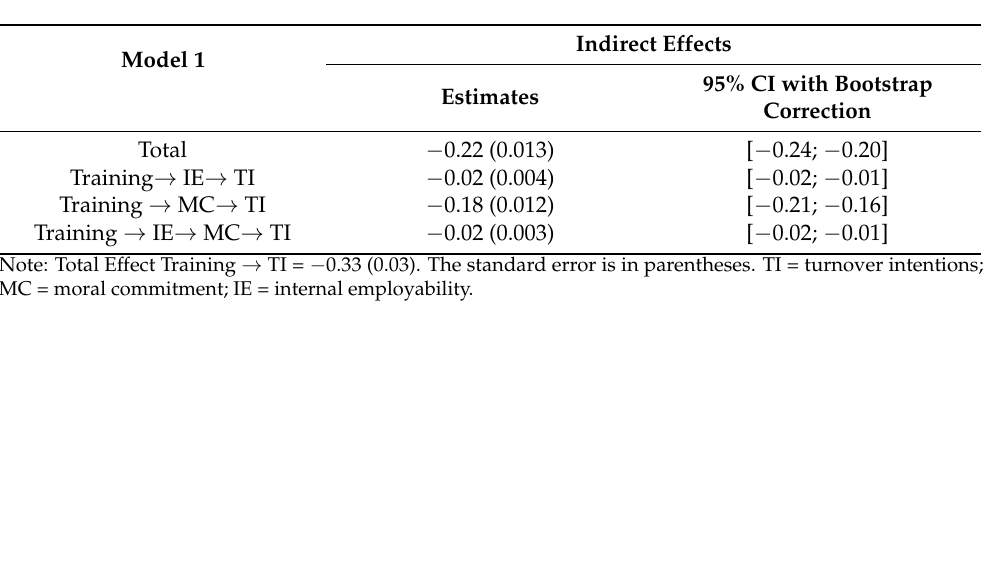
Table 5. Indirect Effects of the Model